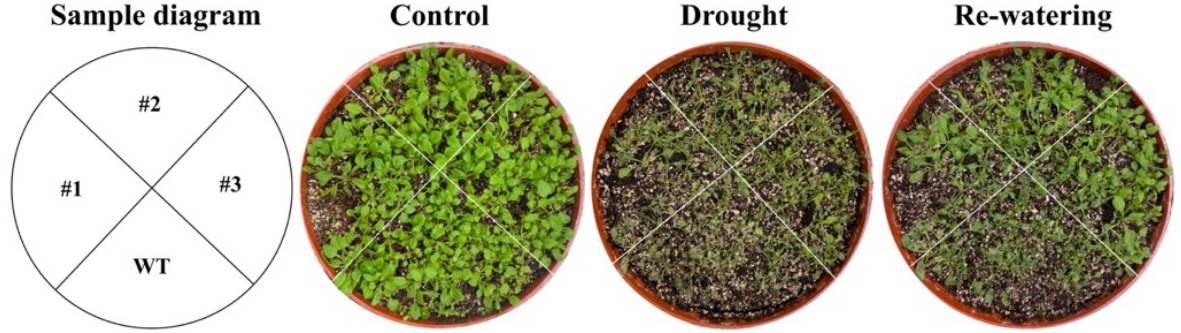
Figure 13. Results of drought resistance experiments of wild type (WT) and three lines of transgenic Arabidopsis thaliana plants with overexpression of GmNAC3 (#1, #2, and #3) under normal growth condition (control), drought stress (i.e., treatment of 12% PEG6000), and recovery of drought stress by re-watering.